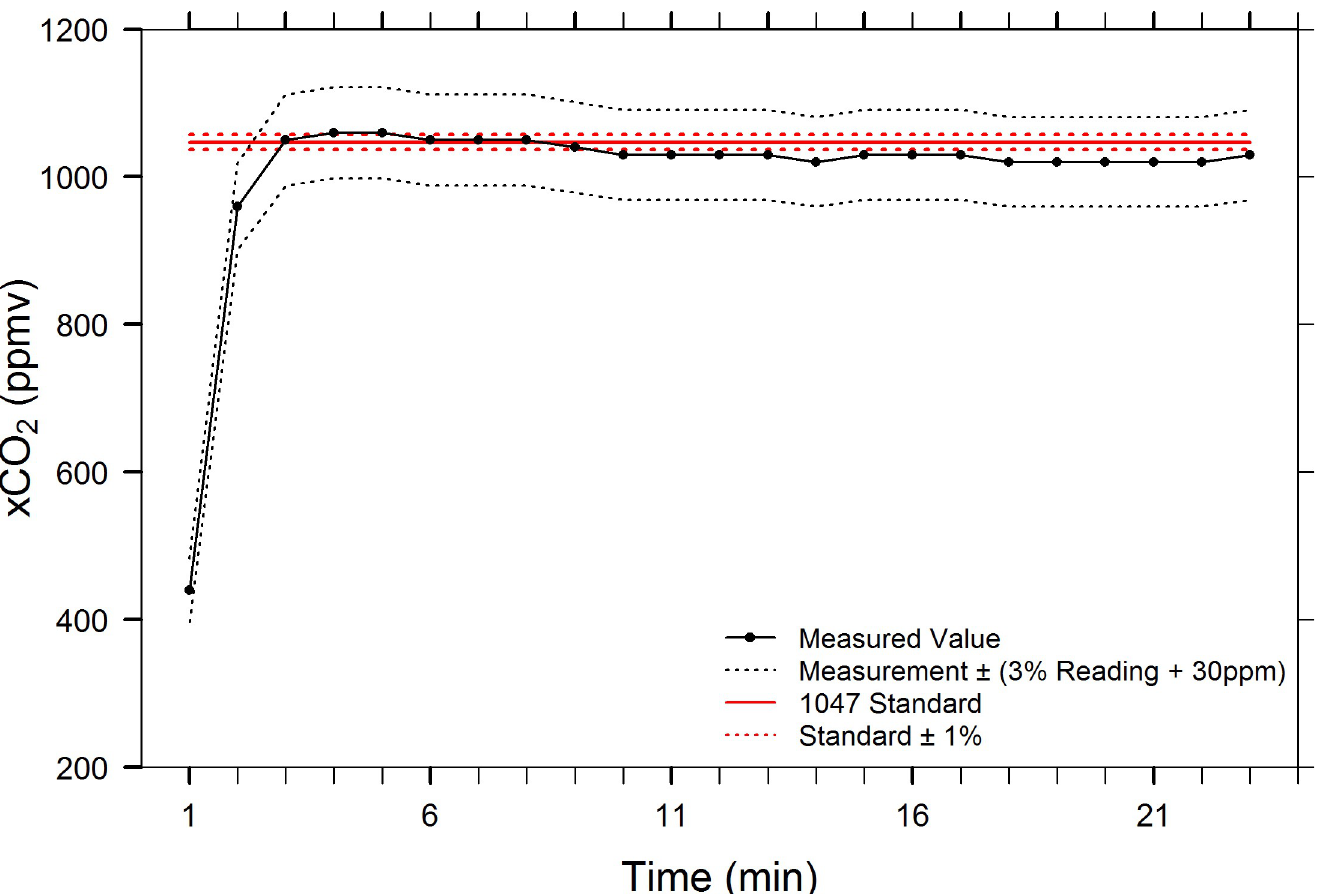
Fig 7. Accuracy test of EQL using 1047 ppmv ± 1% standard (nominal CO 2 concentration). Once equilibration initially reached within 1% of standard, the average xCO 2 = 1034 ± 13.6 (mean ± 1 SD, n =